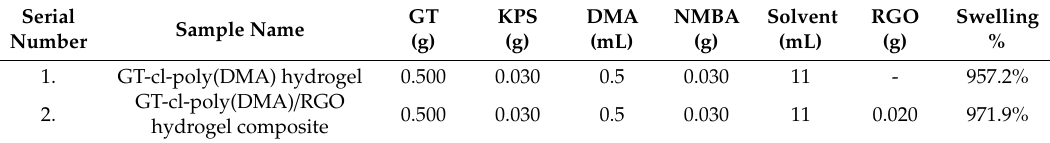
Table 3. Optimized quantities used for the preparation of